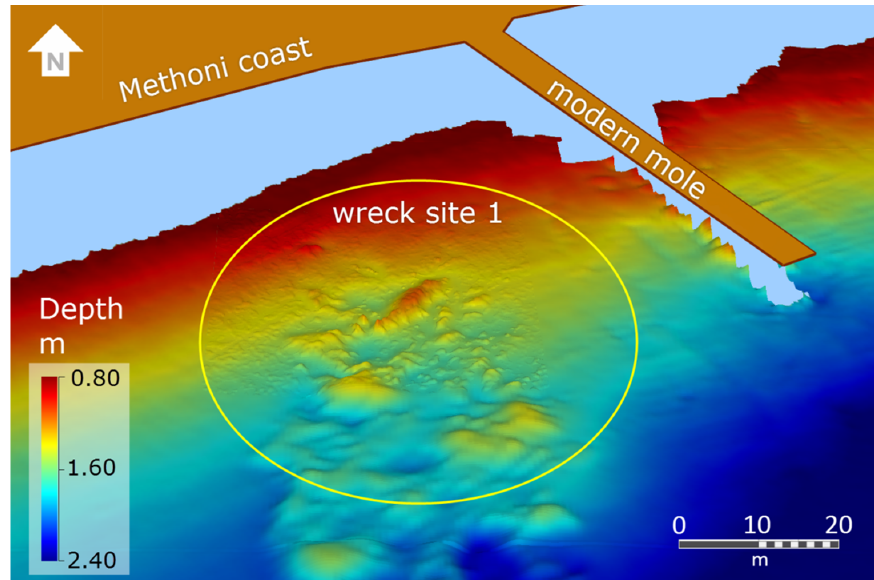
Figure 3. Bathymetric map of the wreck site 1 (within the yellow ellipsis) and approaches. The 3D bathymetric surface is being rendered vertically exaggerated. The length scale and the north arrow direction refer to the centre of the image.